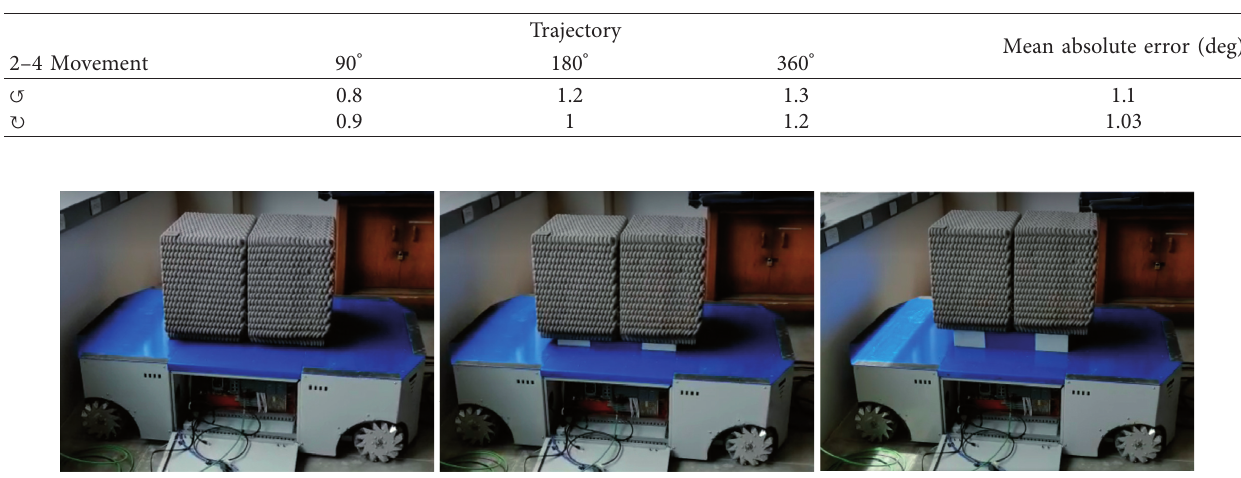
Table 5: Rotational movement errors in the kinematic model.